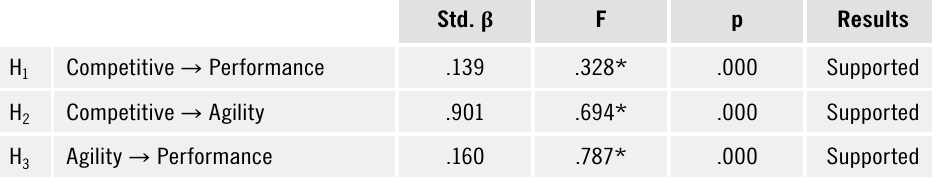
Table 6. Regression analysis results